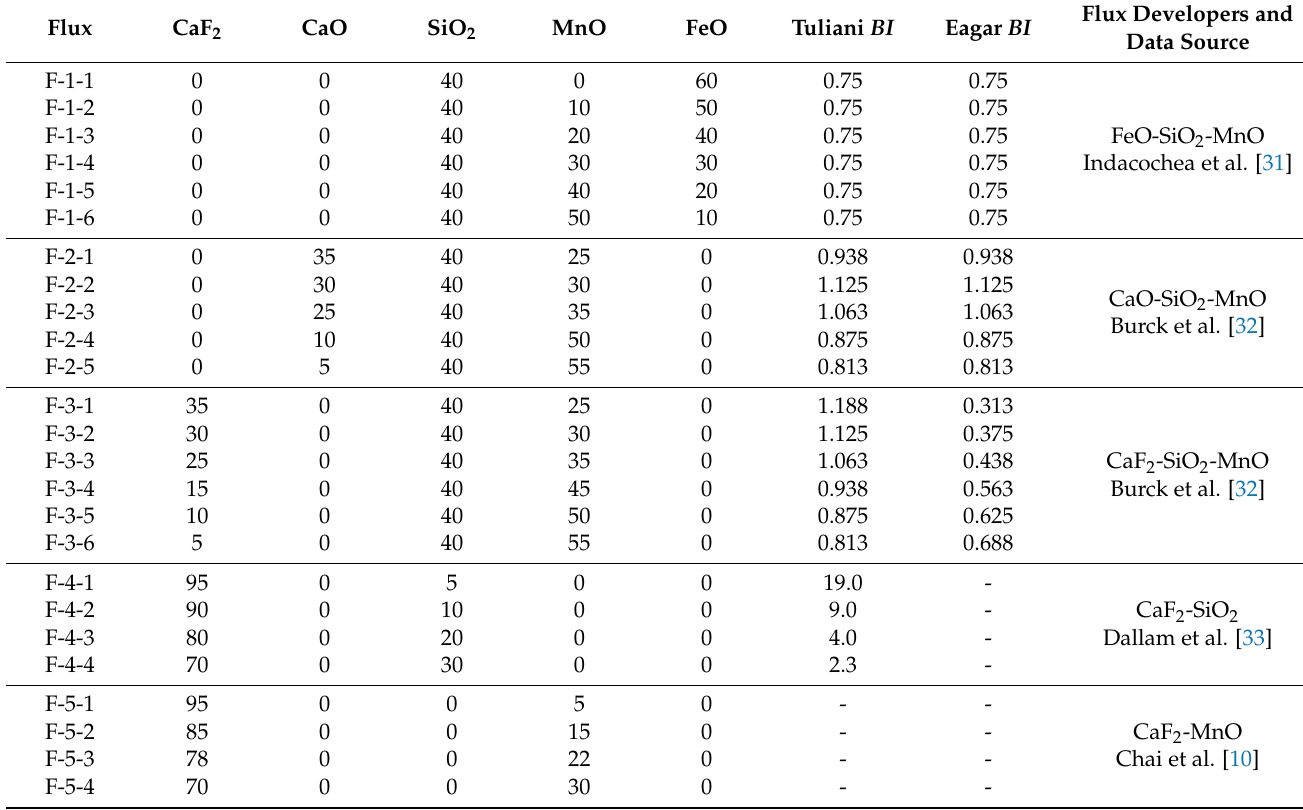
Table 1. Summary of flux formulas in this